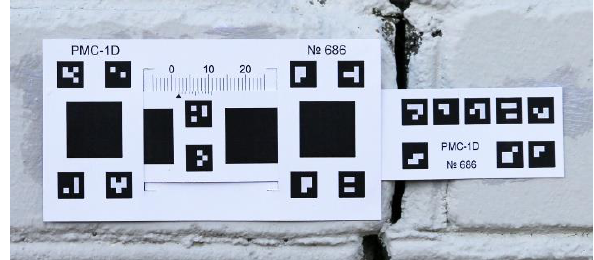
Figure 4. Installation of crack monitoring marker.